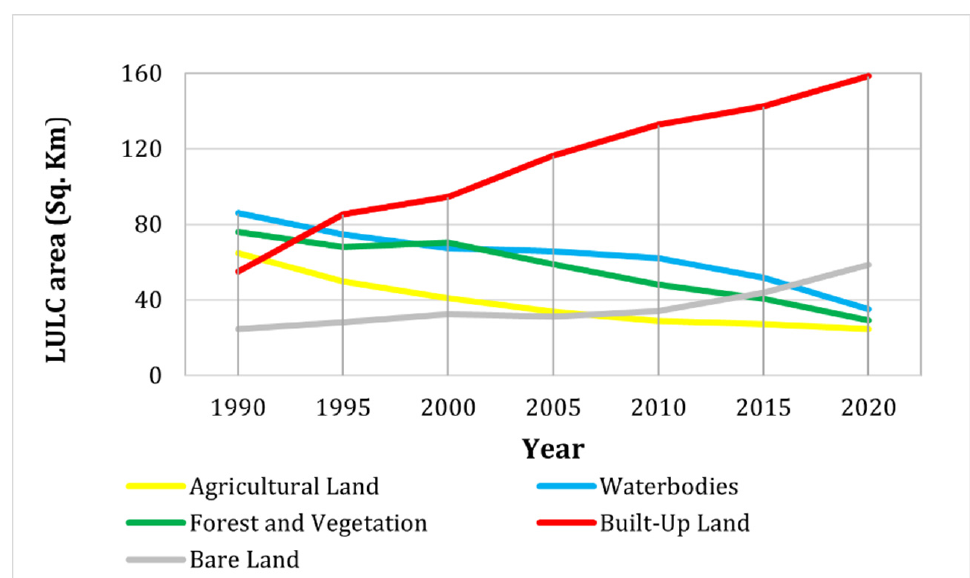
Figure 3. Figure showing trend of LULC change in Dhaka during 1990–2020. Figure 3 shows the trends of LULC changes of Dhaka during the period from 1990 to 2020. From this figure, two trends of LULC change are evidently identifiable. Firstly, agricultural land, waterbodies, and forest and vegetation show a gradual decrease over the last three decades; secondly, built-up area and bare land show a gradual increase over the period. These trends imply that a considerable portion of agricultural land, waterbodies, and forest and vegetation were occupied by built-up area and bare land in the study area in the past 30 years. Table 4 shows the distribution of different LULC types during the period 1990 to 2020 in the study area. In 1990, the dominant LULC type was waterbodies (85.85 km 2 ), and the lowest portion of land remained bare land (24.52 km 2 ), whereas in 2020, the highest amount was land was allocated to the built-up area, and the lowest amount of land was occupied by agricultural land. However, except in 1990, the built-up area constituted the dominant LULC type up to 2020, having a proportion of about 27.88%, 30.91%, 38.09%, 43.38%, 46.57%m and 51.85% 1995, 2000, 2005, 2010, 2015, and 2020 respectively. Table 4. Area and proportion of different LULC